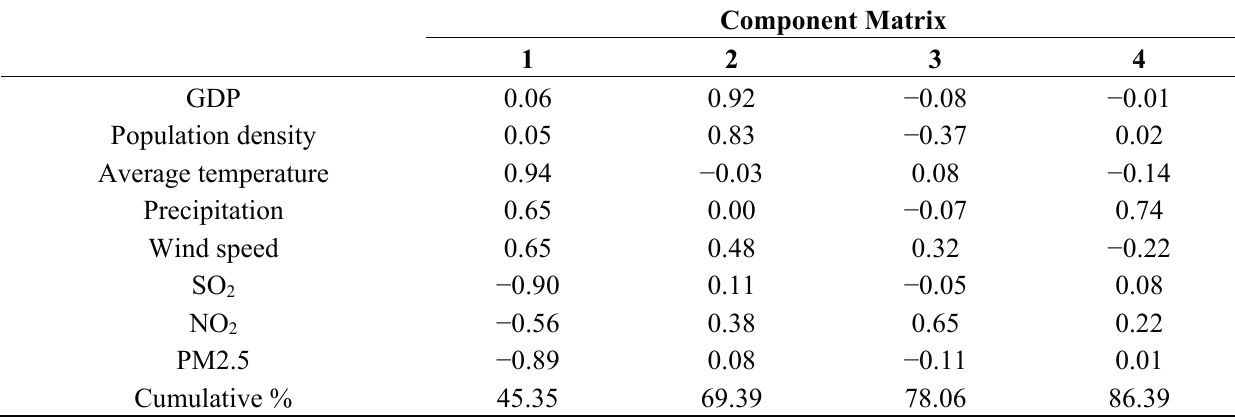
Table 2. Principal component analysis (PCA) for PM2.5 concentration and influencing factors in Xi’an,